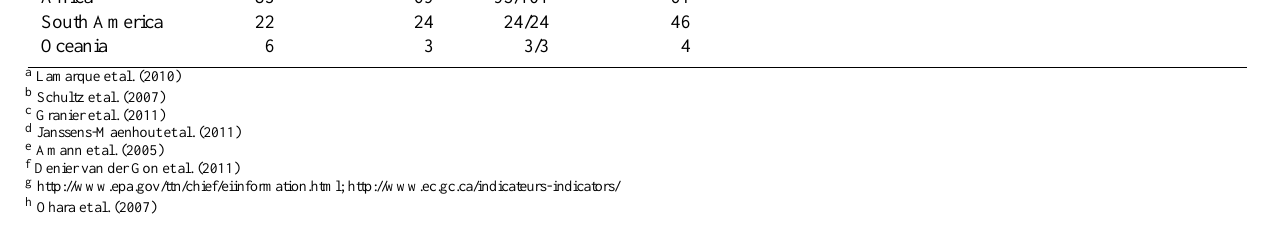
Table 2. Global and regional 2005 CO emission totals from recent biomass burning and biogenic emission inventories in teragrams per year. Data are available from the ECCAD